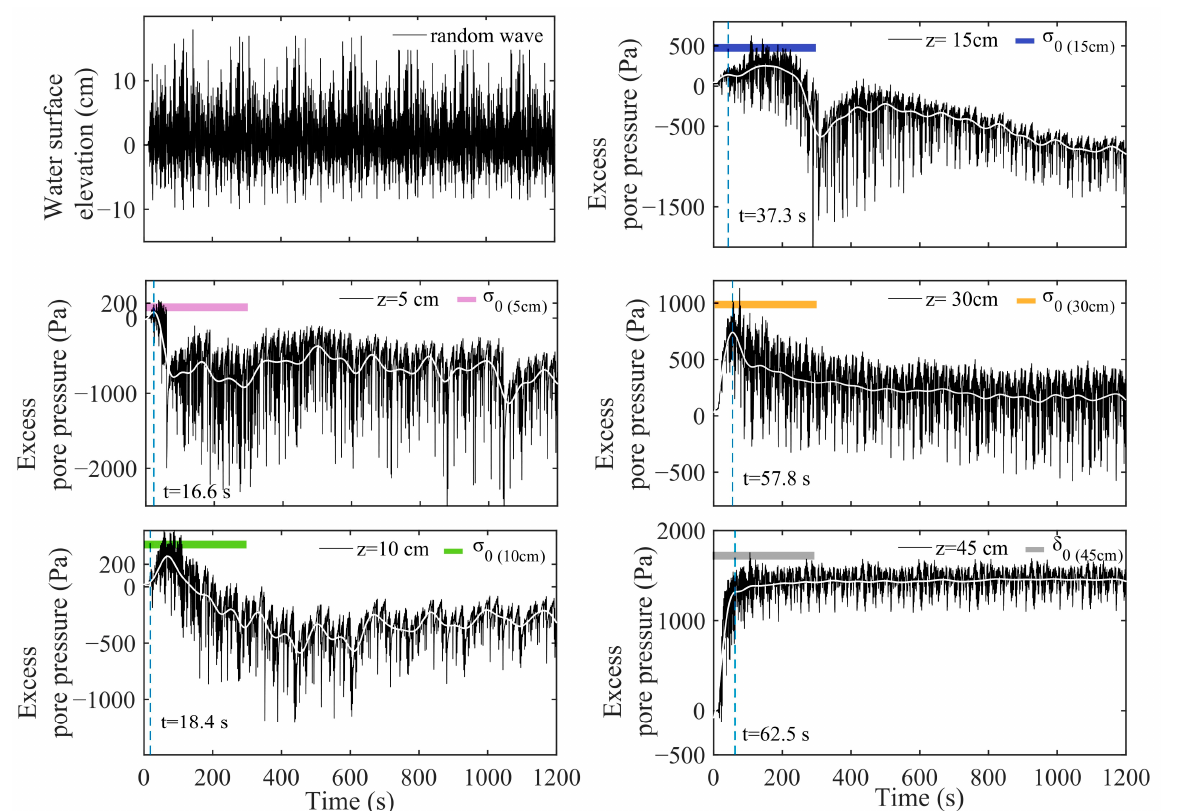
Figure 4. Time-series of random waves and excess pore pressure at various depths in experiment IV-2: the shaded bar shows σ 0 , the initial mean normal effective stress of the seabed; and the white curve shows cumulative pore pressure.